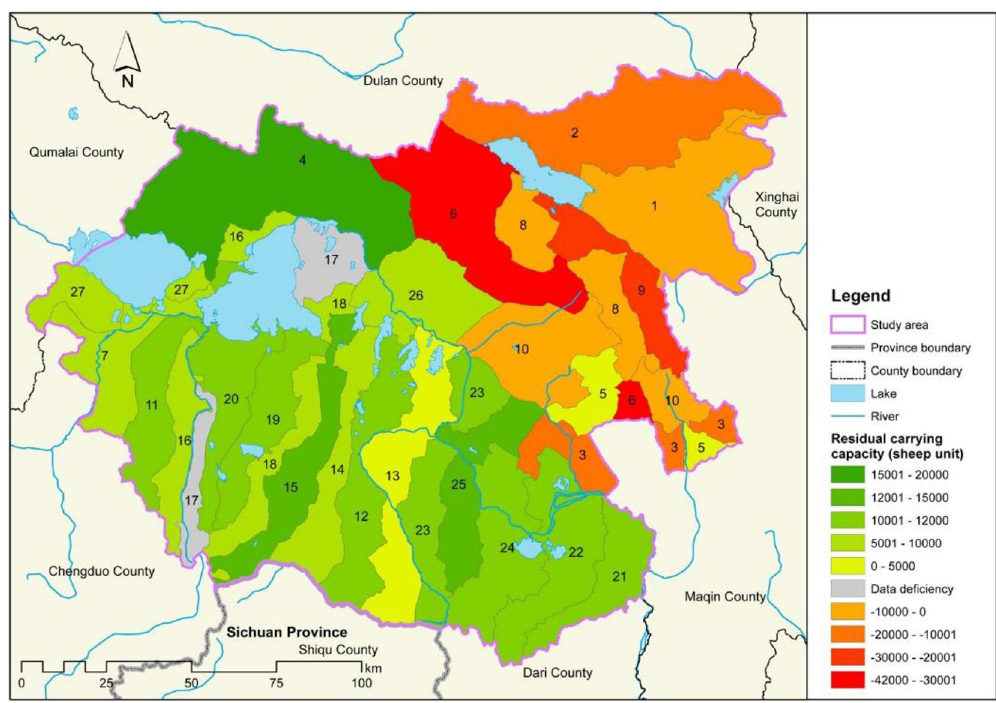
Figure 4. Residual carrying capacity in Maduo (with two wild ungulate species). The map was generated using ArcGIS 10.2 (https ://deskt op.arcgi s.com/en/) based on shapefiles and data collated for this